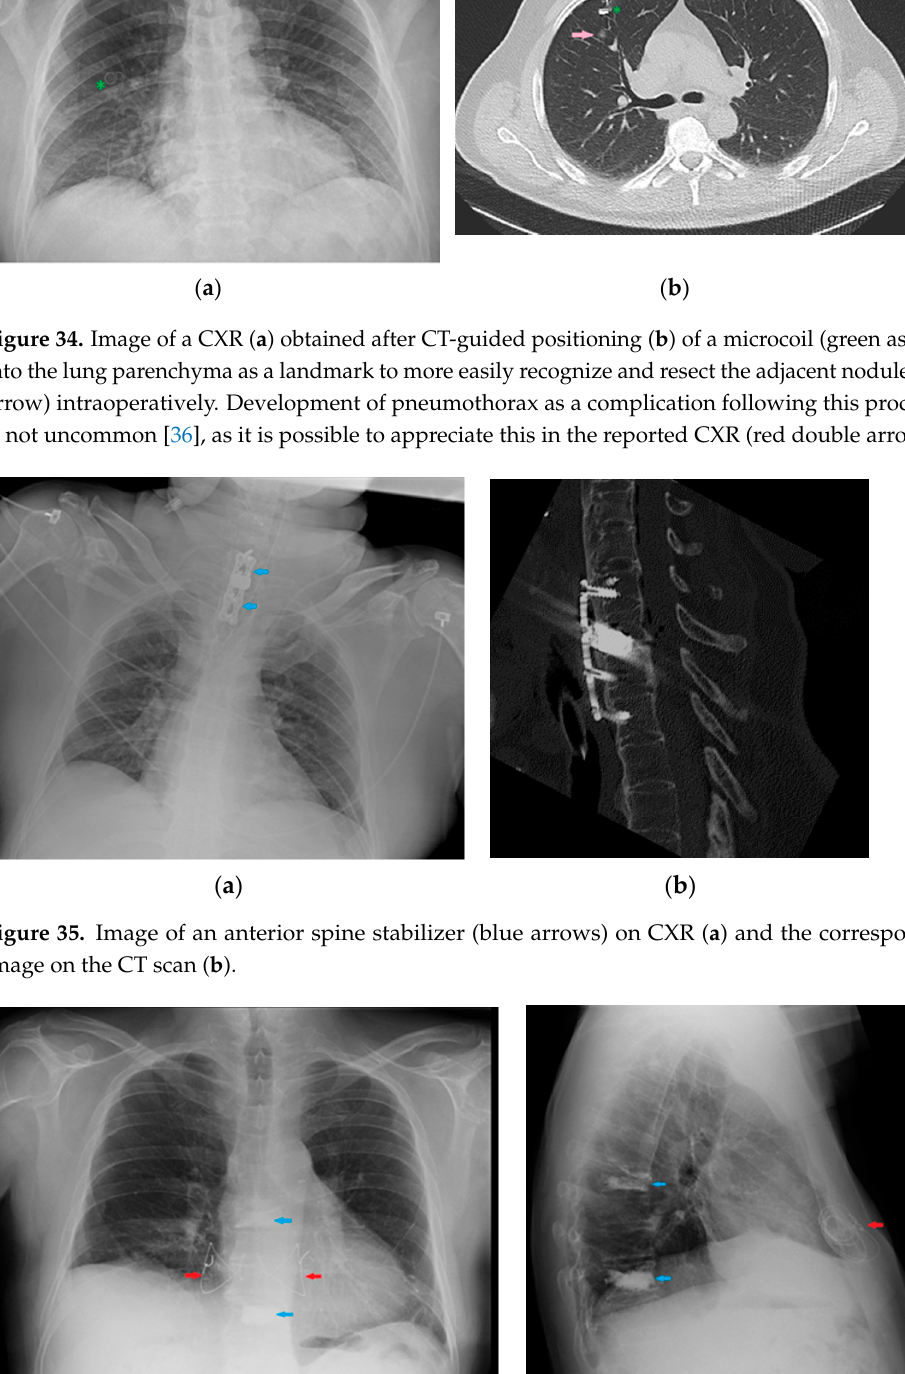
( b ) Figure 37. Image of an IVC filter on PA ( a ) and LL ( b ) views of a CXR (green arrows).